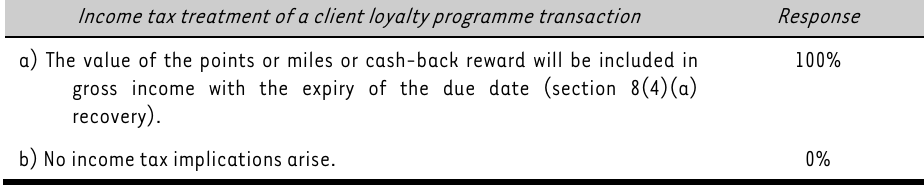
Income tax treatment of expired points or miles over two years of assessment